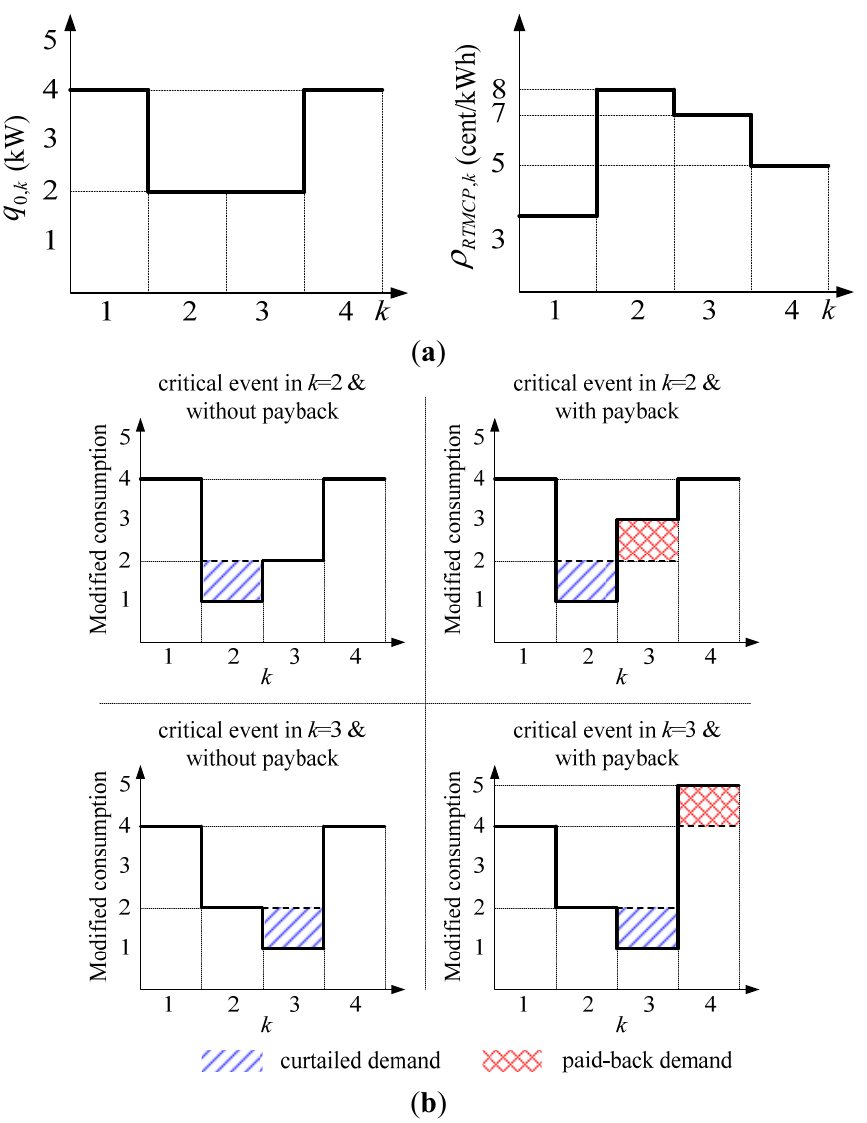
Figure 2. ( a ) Demand and real-time market clearing prices (RTMCPs); ( b ) A